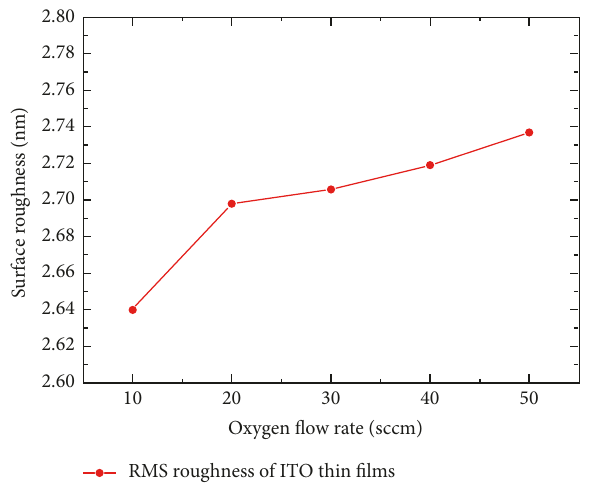
Figure 7: Surface roughness of ITO thin films as a function of oxygen flow